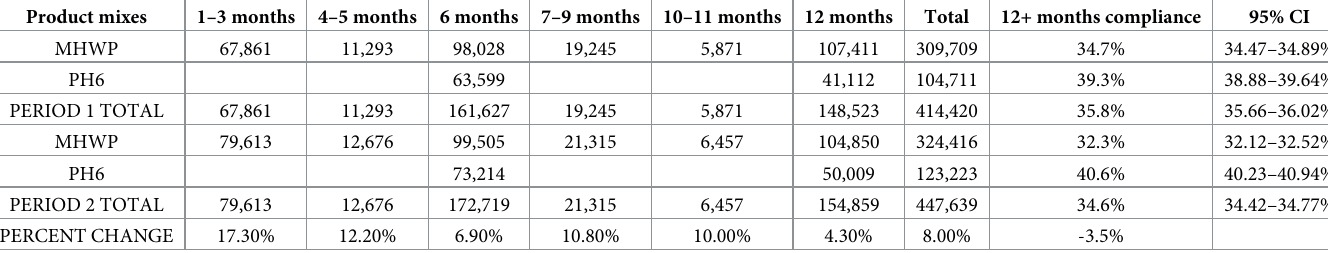
Table 8. Patient level comparison of doses purchased Period 1 vs Period 2. PH 6 only users. Product